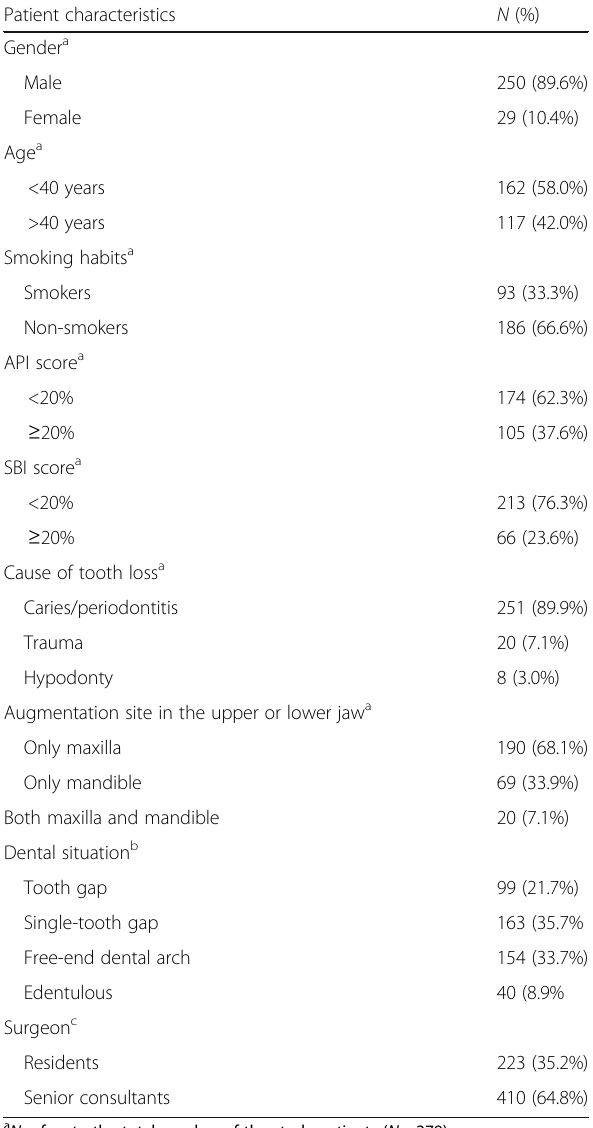
Table 1 Patient characteristics at the time of augmentation Patient